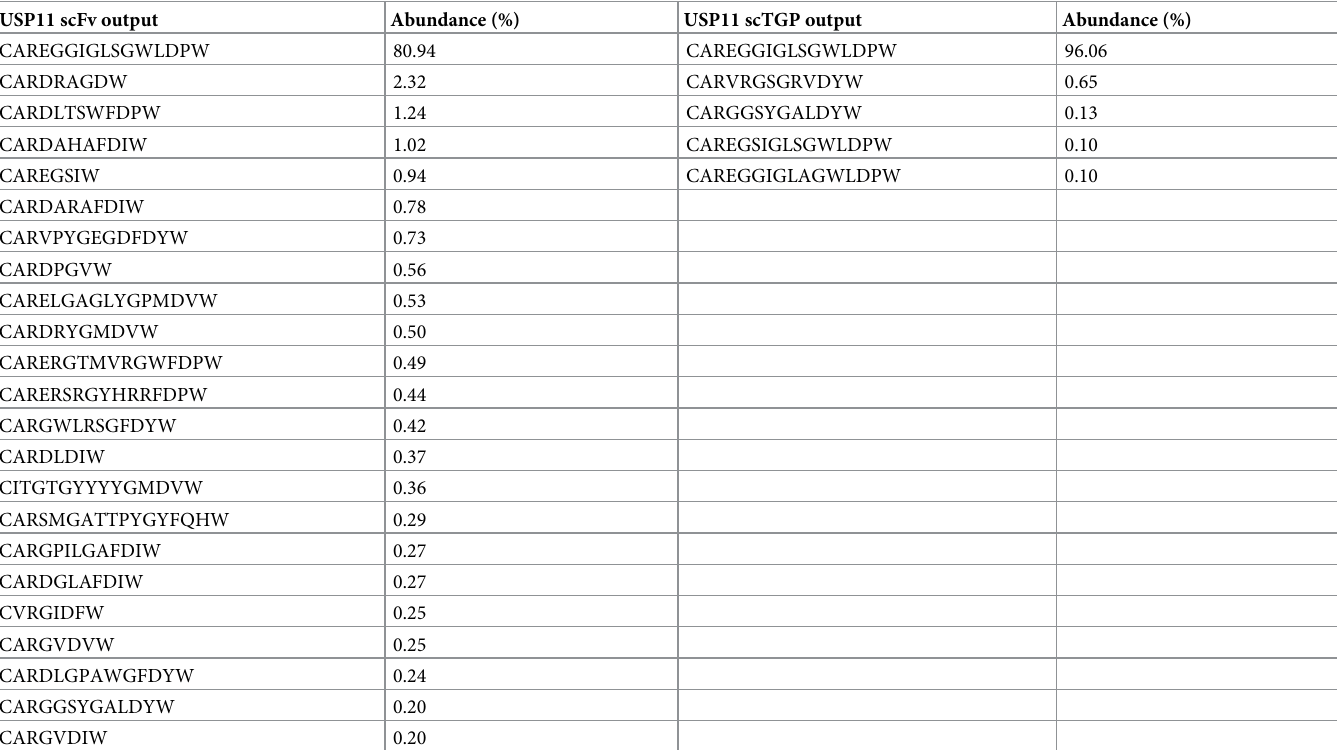
Table 3. VH-CDR3 amino acid sequences of scFv and scTGP clones that recognize USP11 with relative abundance of each clone in the sorted yeast sub-libraries. Identical CDRS in both libraries are indicated with same colors.